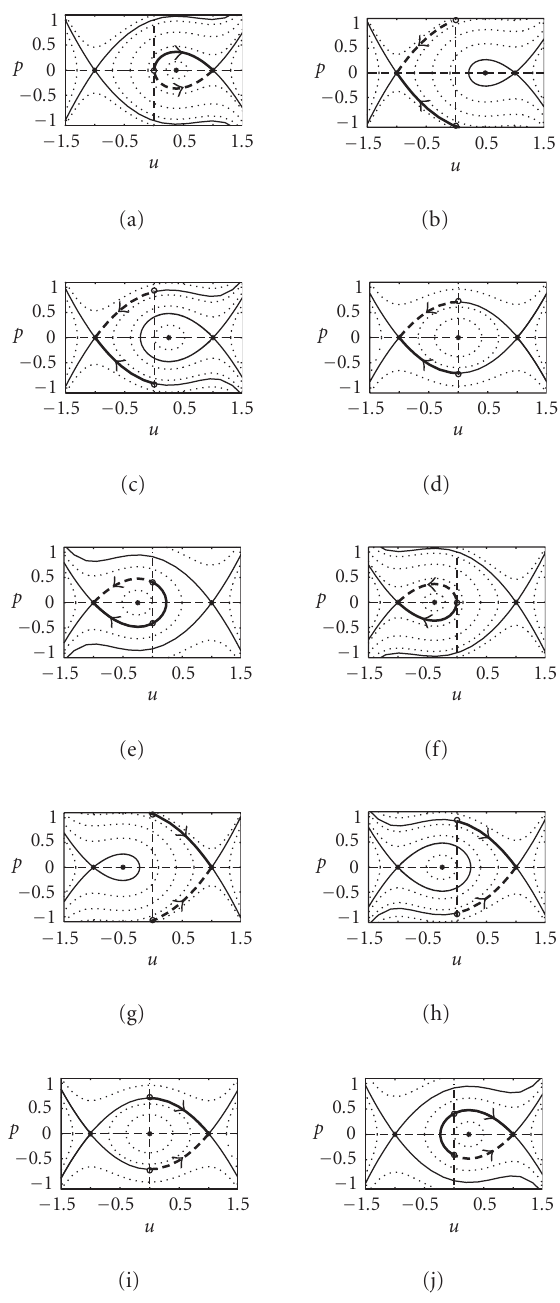
Figure 3.3. Phase portraits illustrating time dynamics of the boundary layer transitions present near the left (solid line) and the right (dashed line) boundaries of the interval x ∈